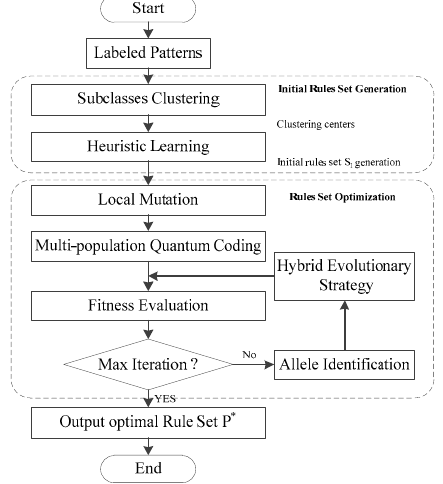
Figure 3. Flow chart of fuzzy rules mining based on MPQEA.